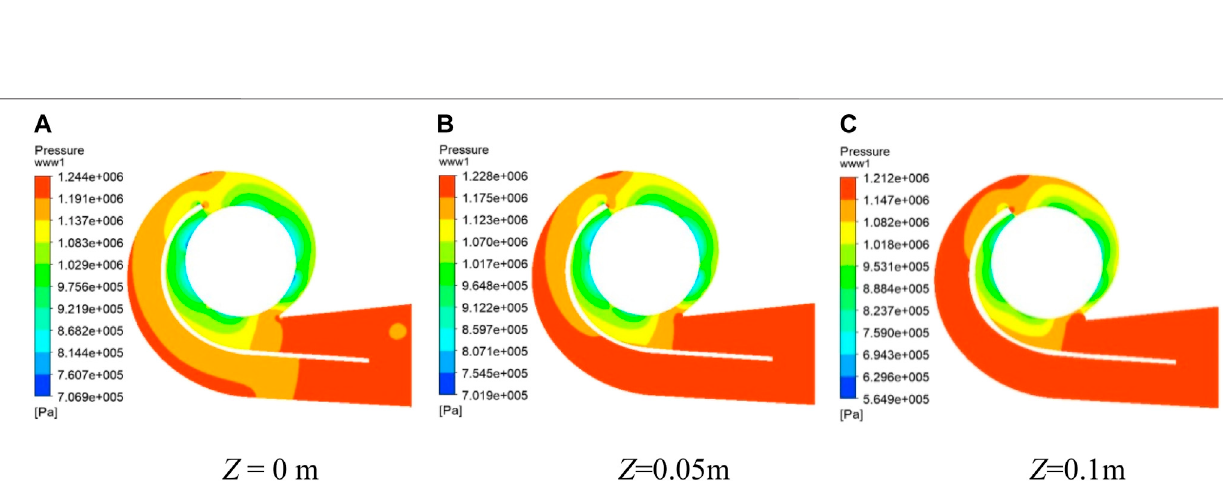
FIGURE 6 | Impeller cross-sectional pressure diagram at Q = 4.0 m 3 /s. Z in represents different cross-sectional heights.